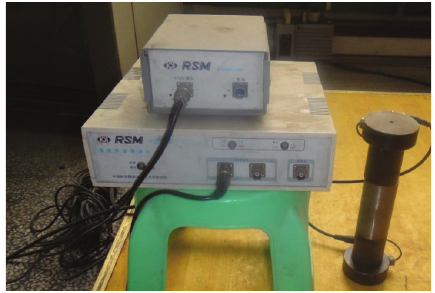
Figure 2: Sketch map of the acoustic wave detector RSM-SY5.